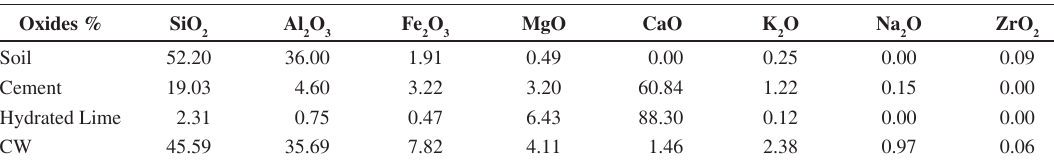
Table 1. Chemical composition of soil, waste and binding agents. Oxides